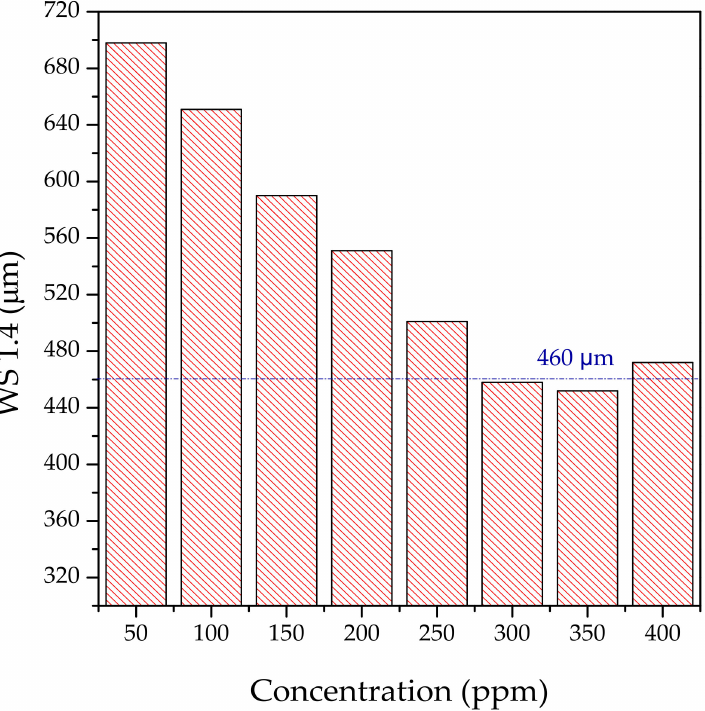
Figure 8. Impact of tobacco seed oil N , N -Bis(2-ethoxyethyl) amides addition on the lubrication characteristics of the base